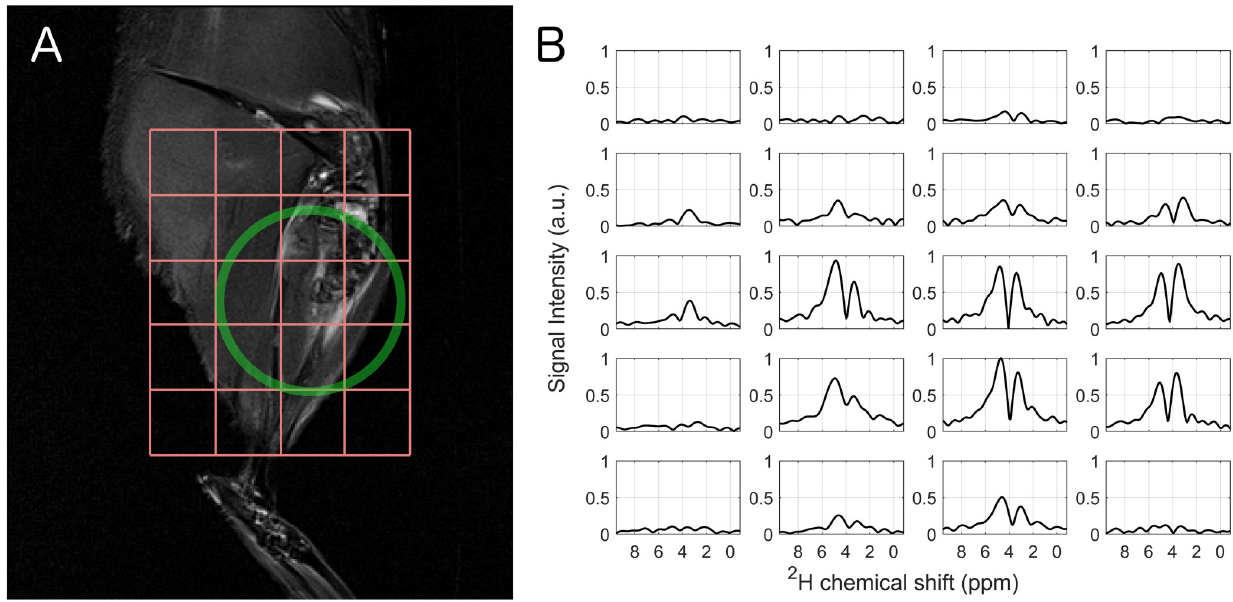
Fig 4. Chemical shift imaging of the rat leg (results from rat 3). A Position of the grid relative to the leg and approximate position of the coil. The image was acquired with a T 2 weighted turbo spin echo sequence and shows the metastases in the upper right half of the grid. The image represents a 1 mm thick slice within the CSI volume. B The deuterium spectra show an inhomogeneous intensity distribution due to the sensitivity profile of the loop coil, yet the OMG and water peak are clearly visible and